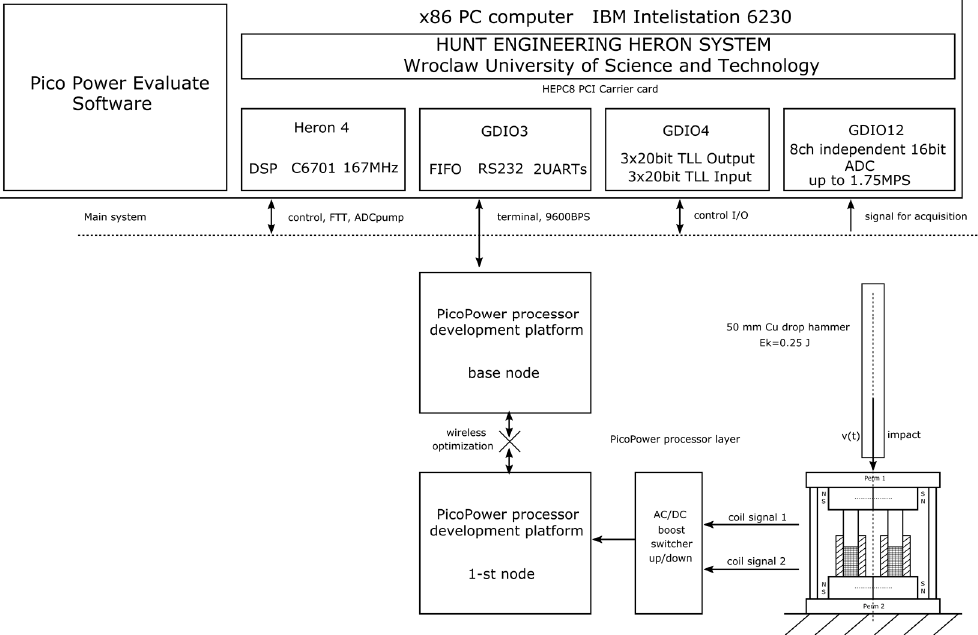
Figure 8. The PicoPower Development Platform was applied as a system to construct a new type of harvesting power supply.